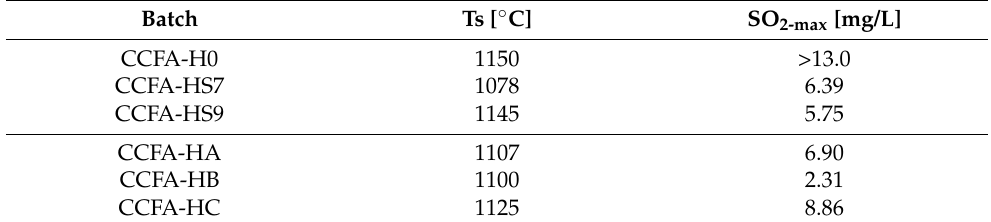
Table 8. The temperatures of anhydrite decomposition start (Ts) and the maximum measured quan- tity of SO 2 in the flue gas during the firing (SO 2 -max).